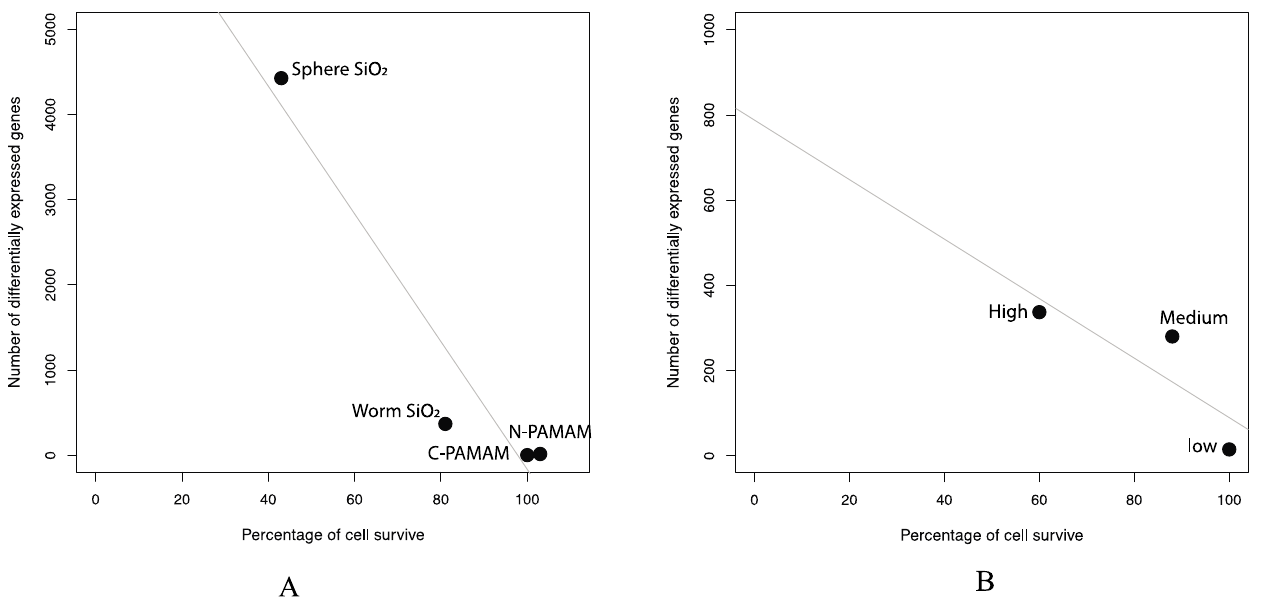
Figure 1. The correlation between the number of differentially expressed genes identified from toxicogenomics studies and cell survival. ( A ) In data set 1, four type of nanoparticles were compared. ( B ) In data set 2, three concentrations of 10 nm silica nanoparticles (5 µ g/mL, 20 µ g/mL, and 50 µ g/mL) were